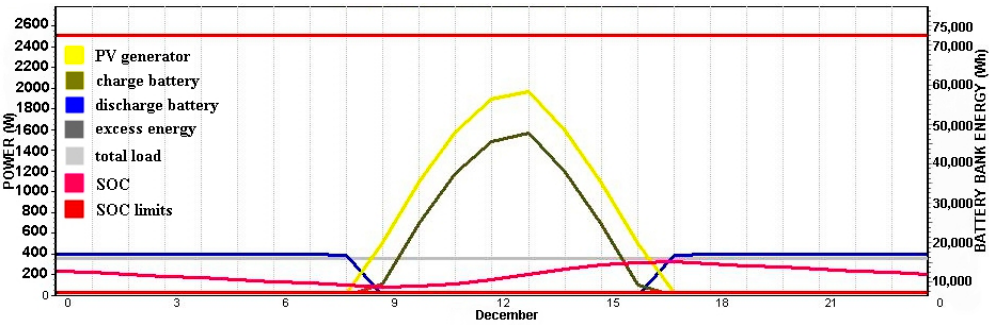
Figure 8. Hourly results for the worst day of system operating.